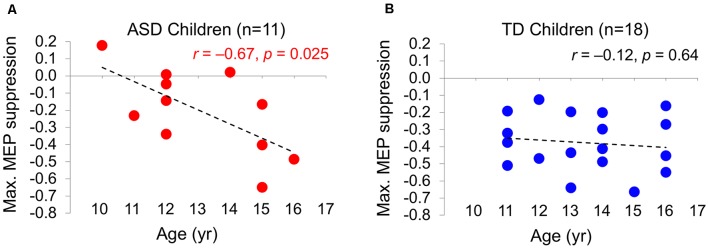
The relationship between the maximum cTBS-induced suppression in the natural log-transformed, baseline-corrected MEP amplitude (Max. MEP suppression) and age in ASD (A) and TD (B) groups. Max. MEP suppression was negatively correlated with age in the ASD group (r = –0.67, P = 0.025), but not in the TD group (r = –0.12, P = 0.65). Dashed lines represent the slopes of the linear regression fit. ASD, autism spectrum disorder; cTBS, continuous theta-burst stimulation; MEP, motor evoked potential; TD, typically developing.